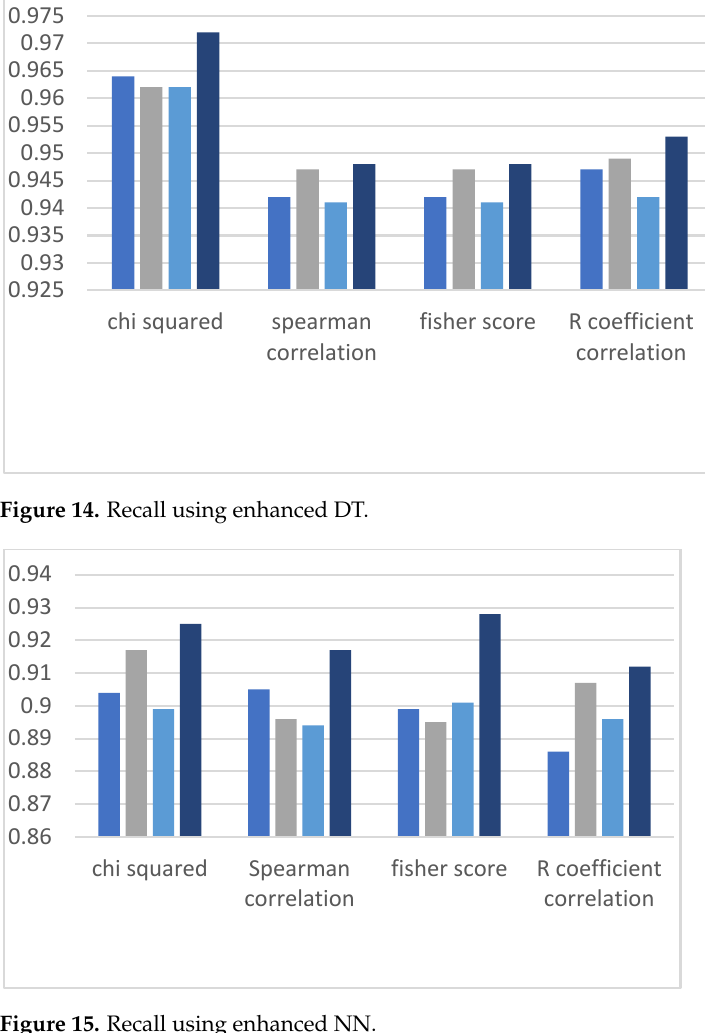
Figure 13. Recall using enhanced SVM.